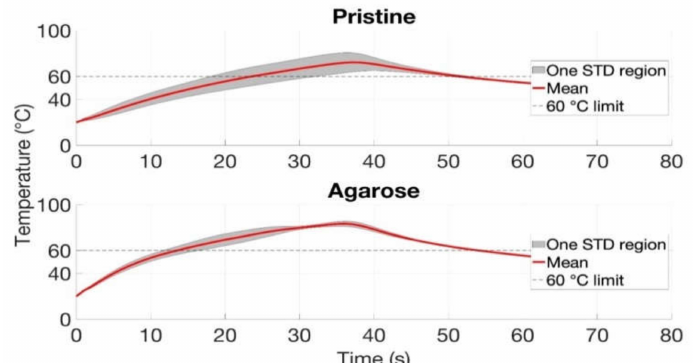
Figure 11. The maximum temperature values achieved during RFA over time in the presence of blood-mimicking system oriented perpendicularly to AE. The maximum values were reached before 40 s followed by a gradual decrease in both pristine and agarose-injected tissues. The analysis included the mean and standard deviation values evaluated over three trials for each